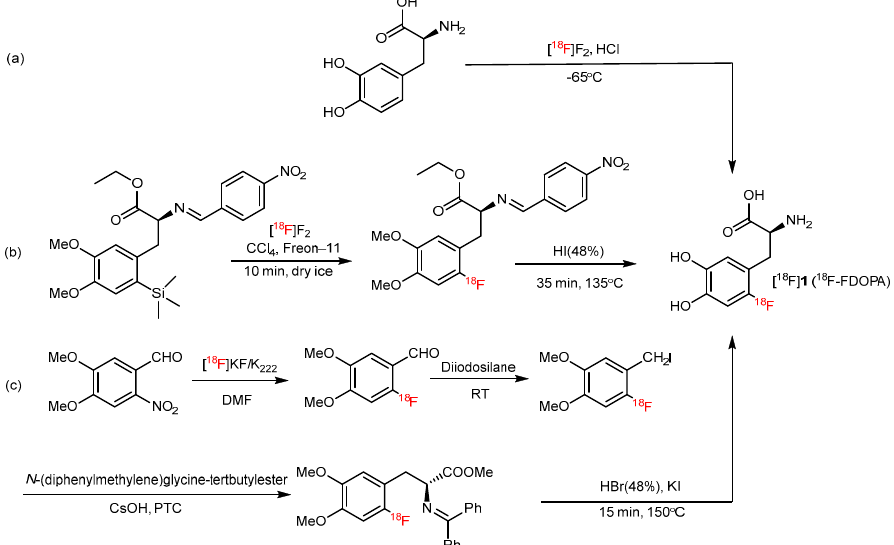
Figure 1. ( a ) Synthesis of [ 18 F] 1 through [ 18 F]F 2 . Modified from Firnau et al. [22]. ( b ) Electrophilic synthesis of [ 18 F] 1 . Modified from Diksic et al. [23]. ( c ) Synthesis of [ 18 F] 1 through an asymmetric alkylation by Shen et al. [27].